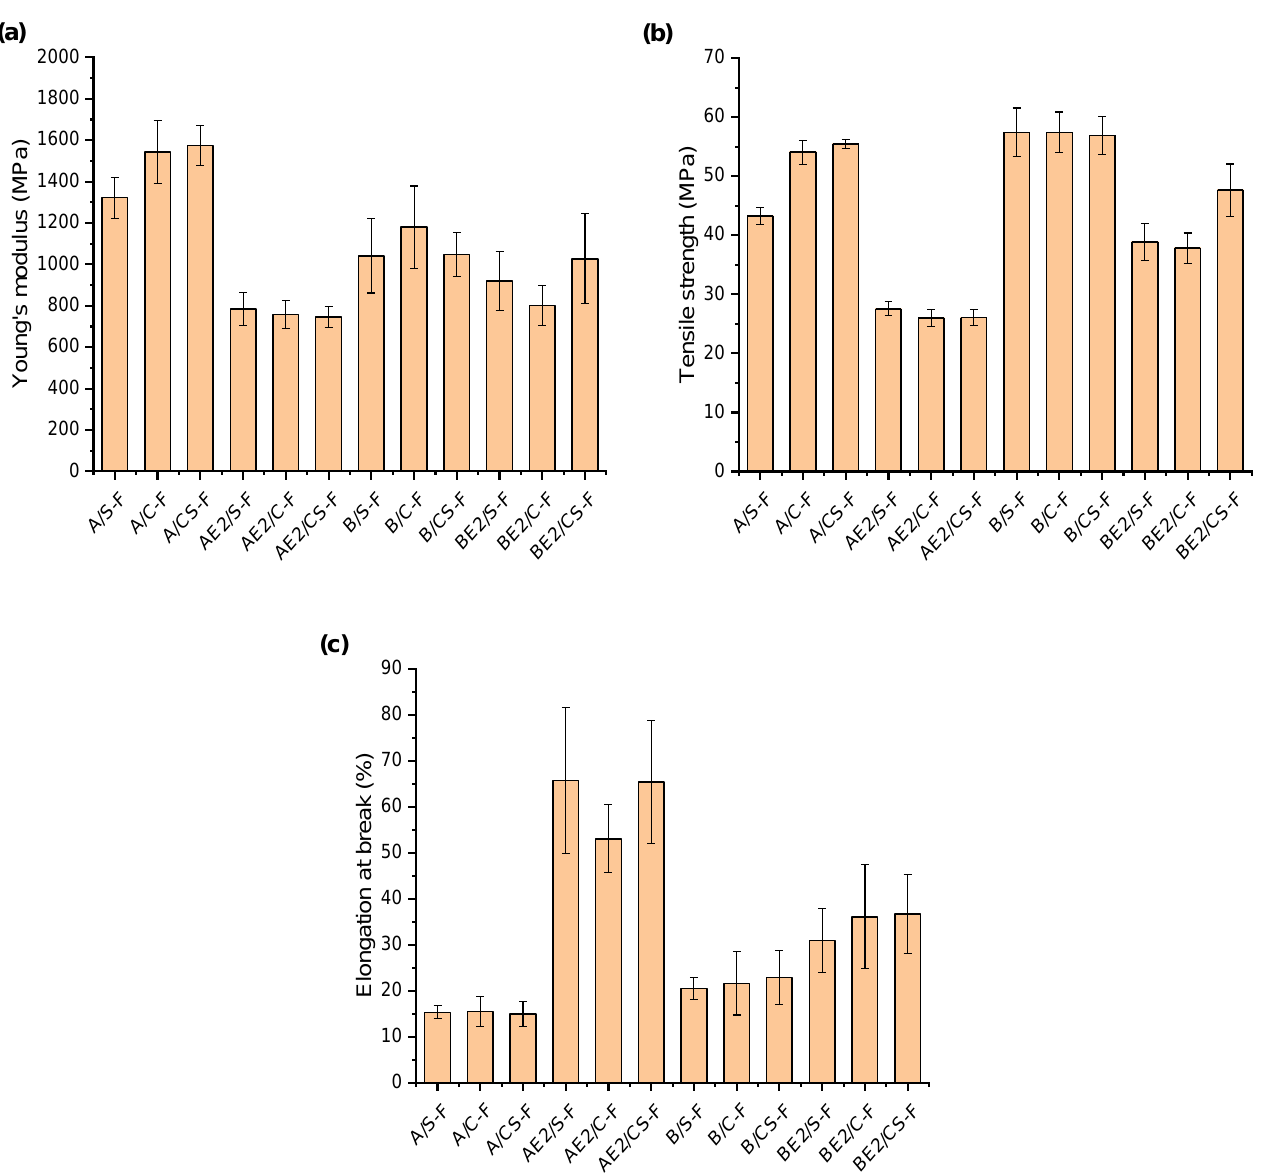
Figure 6. ( a ) Young’s modulus, E ( b ) tensile strength, σ t , and ( c ) elongation at break, ε b , of the different bionanocomposite Figure 6. a) Young’s modulus, E b) tensile strength, σ t , and c) elongation at break, ε b , of the different bionanocomposite films. Error bars represent standard films. Error bars represent standard deviations.